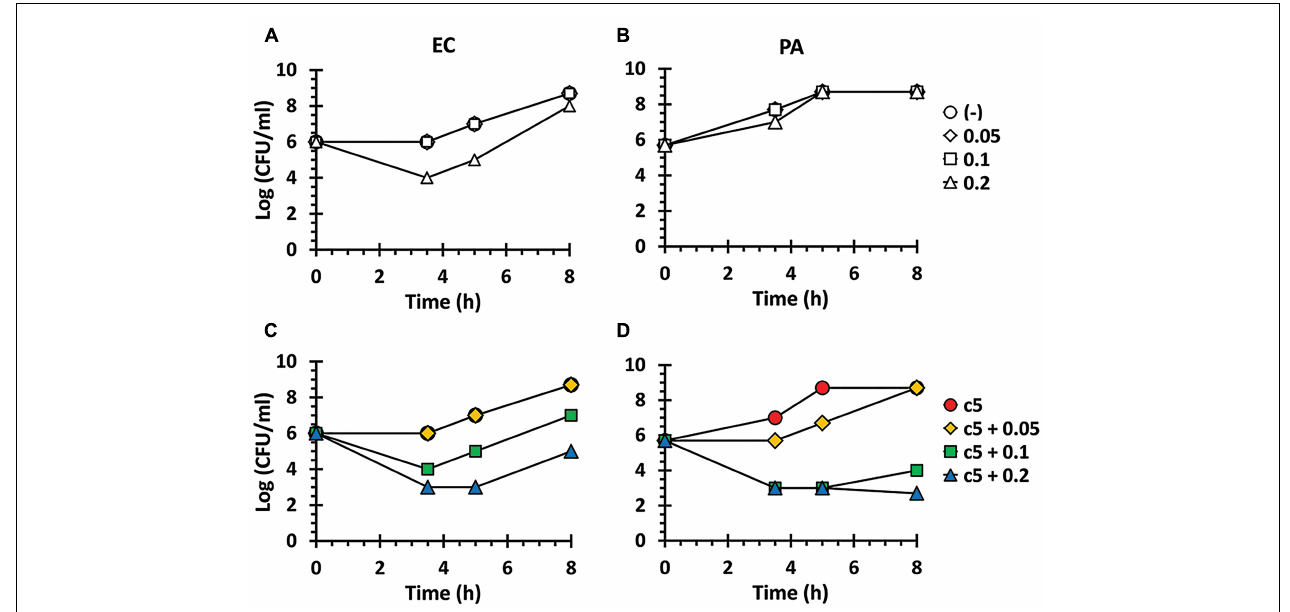
FIGURE 2 | Antibacterial activity in the presence of polymyxin B (PMB). Antibacterial activity against E. coli (EC) (A,C) and P. aeruginosa (PA) (B,D) in the presence of PMB. The EC and PA culture suspensions (5 × 10 5 CFU/ml) were incubated in LB broth with nothing (open circle), with c5 (12.5 µ g/ml) only (filled circle), with PMB (0.05, 0.1, or 0.2 µ g/ml) only (A,B) , or with both c5 (12.5 µ g/ml) and PMB (0.05, 0.1, or 0.2 µ g/ml) (C,D) . The viable cells were counted by plating onto LB agar plates at the designated time